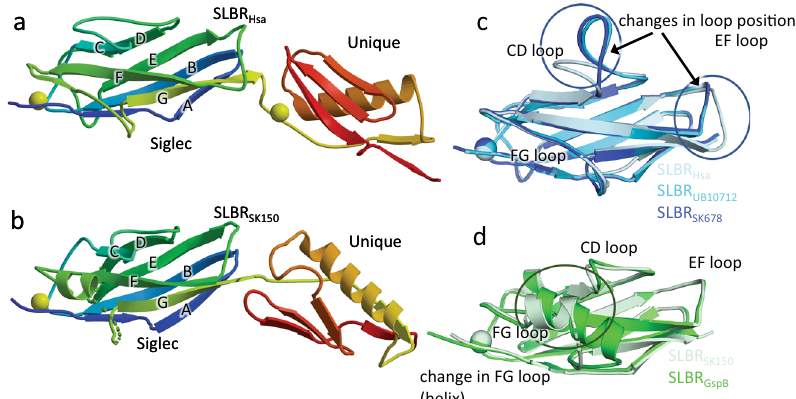
Fig. 3 Structural differences between SLBR Hsa , SLBR UB10712 , and SLBR SK678 . Ribbon diagrams of a SLBR Hsa and b SLBR SK150 with the N-terminus in blue and the C-terminus in red . Ions are shown as spheres. c Overlay of the Siglec domain from the SLBR Hsa ( gray-blue ) SLBR UB10712 ( cyan ) and SLBR SK678 ( blue ). The color of each SLBR is the same as the color of the stars for each strain in Fig. 2. d Overlay of the Siglec domain in the SLBR GpsB ( green ) and SLBR SK150 ( light green ). The CD, EF, and FG loops are highlighted. These are poorly conserved in sequence and length (Supplementary Fig. 4) and display signi fi cant structural